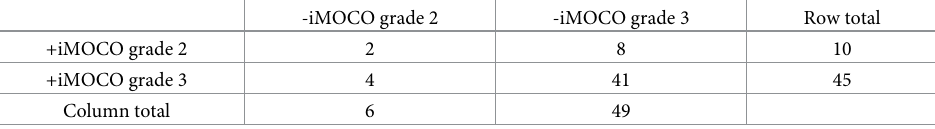
Table 3. Contingency table for the anatomical structure evaluations of the paired T2-weighted scans without motion.